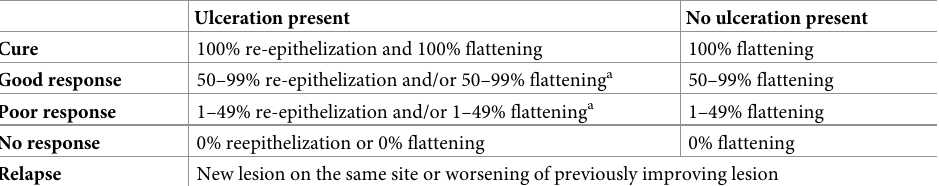
Table 1. Definitions of the different outcome